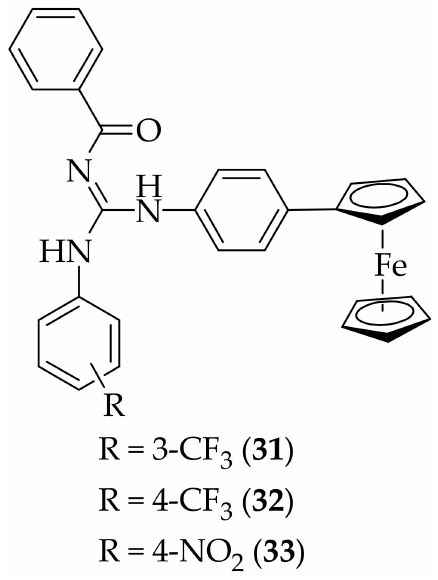
Figure 19. Ferrocene-based guanidine-containing antifungal agents ( 31 ), ( 32 ), and ( 33 ). In 2016, Svenson et al. reported their studies on short cationic antimicrobial pep- tides, [45]. The group synthesized five antimicrobial peptides, designed to illustrate diver- sity in the central amino acid as well as variation in the C-terminal functional group- all five peptides contained two guanidine groups. The five peptides were tested against twenty four pathogenic strains of fungi. Of the five polypeptides, three were found to possess generally potent antifungal activity, and the compound that was focused upon was ( 34 ), Figure 20, with MIC values of between 4 and 64 µ g/mL, although these potencies were appreciably lower than for the positive control utilized, amphotericin B [45]. This com- pound has previously been selected as an antibacterial clinical development candidate by Lytix Biopharma, which they named LTX-109 [46]. Work with this compound is continuing with Amicoat (with the compound renamed as AMC-109) [47] and Pharma Holdings [48]. Compound ( 34 ) was tested for its EC 50 against human erythrocytes, which was found to be 175 µ g/mL. The performance of compound ( 34 ) was analyzed in specific candidiasis and onychomycosis studies. In the candidiasis study, the compound was compared to terbinafine in an assay utilizing human skin. A 2% hydrogel formulation of ( 34 ) produced significant reduction in ATP levels against Candida albicans compared to untreated refer- ences. The compound also showed a significant increase in treatment efficacy compared to terbinafine. In the onychomycosis study, ( 34 ) was tested versus amorolfine as positive control and deionized water as placebo. The study, run over 48 h, demonstrated